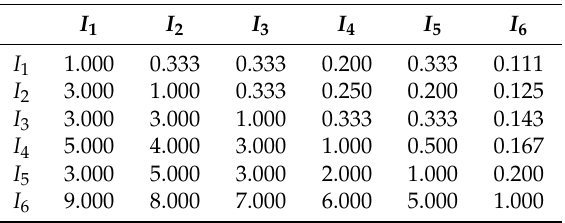
Table A1. Judgment matrix of the criteria layer